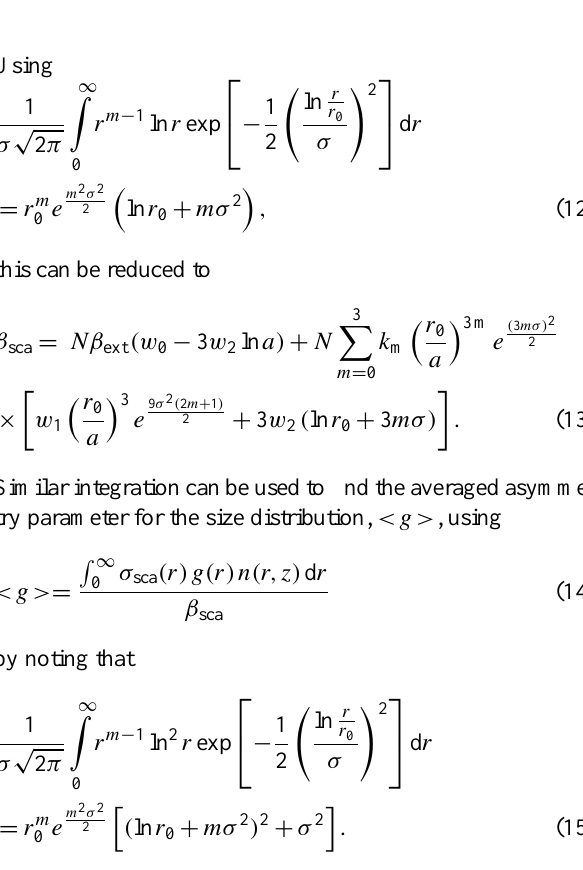
Figure 9. The optimum fitted sphere parameters ( r , n , and k ) and their resultant relative errors in ln σ ext and ln σ sca , and absolute errors in g for λ = 12µm. In this case, the errors on g have been allowed to be large in order to get good fits in the cross sections. As a result, the fitted radius is close to the radius of equal volume (not shown), and the refractive indices are close to those used by the MSTM calculations ( m = 2 . 93 + 2 . 16 i